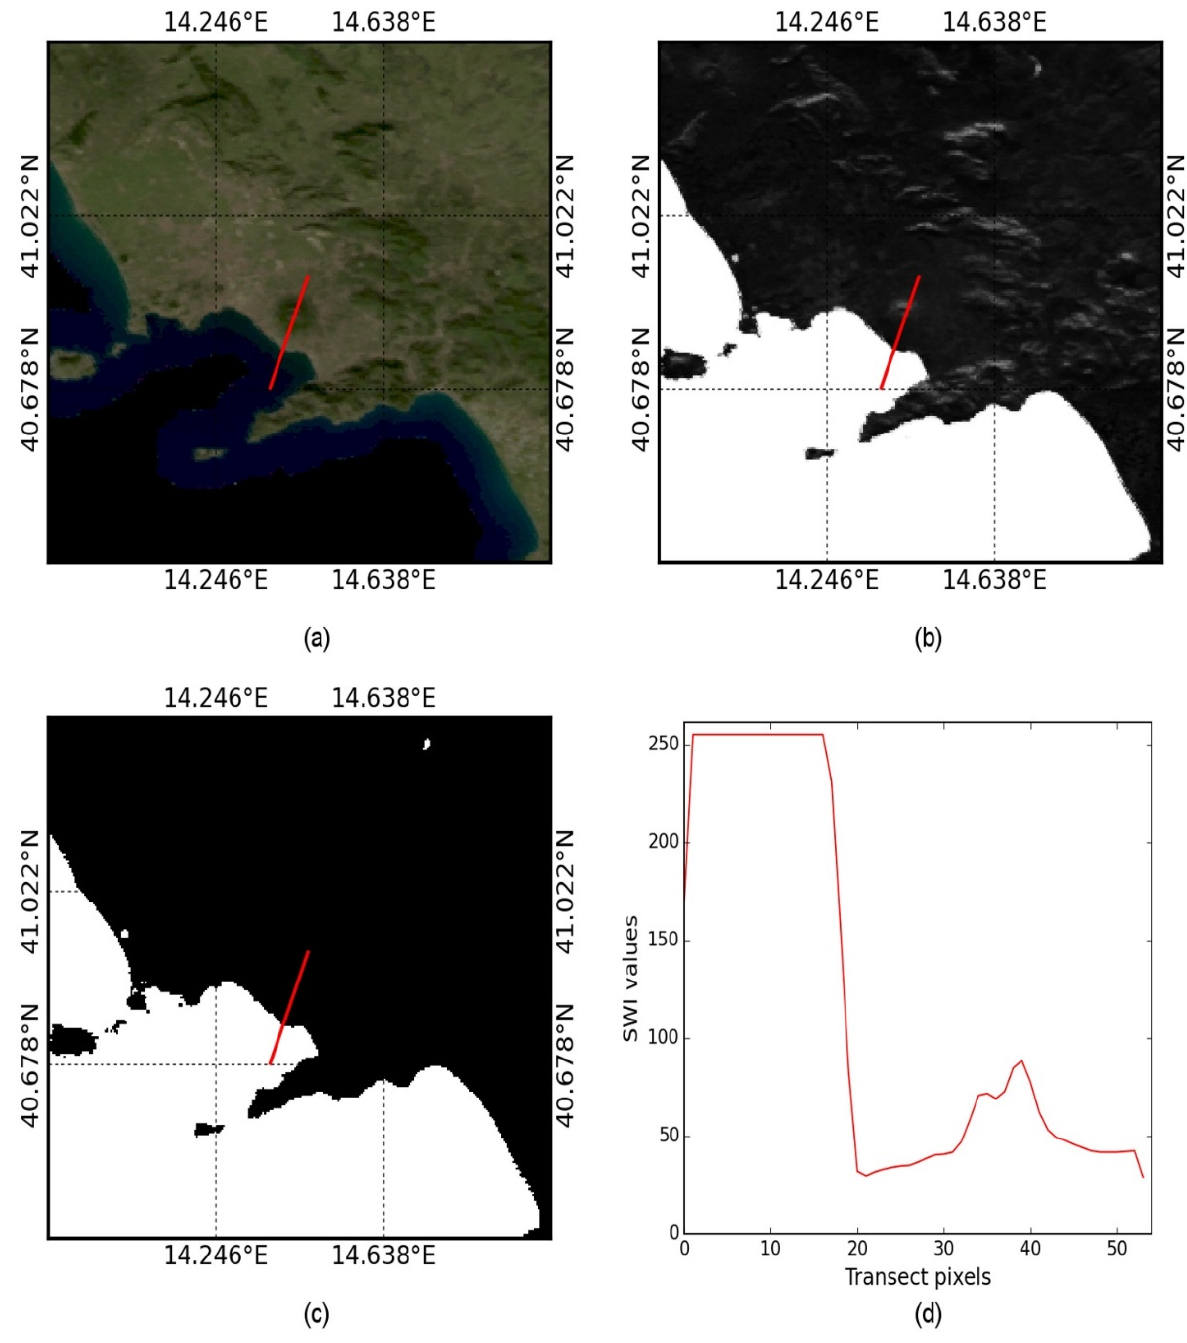
Figure 19. Performance of SWI based extraction of water cover in the case of volcanoes: ( a ) MODIS true-color image, ( b ) SWI image, ( c ) Extracted water cover, ( d ) Profile plot of SWI along the red line